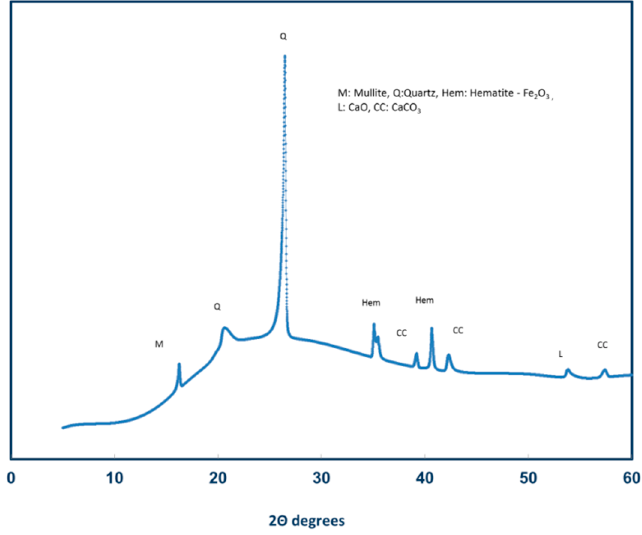
Figure 9. XRD di ff raction pattern of FA. Figure 9. XRD diffraction pattern of FA.